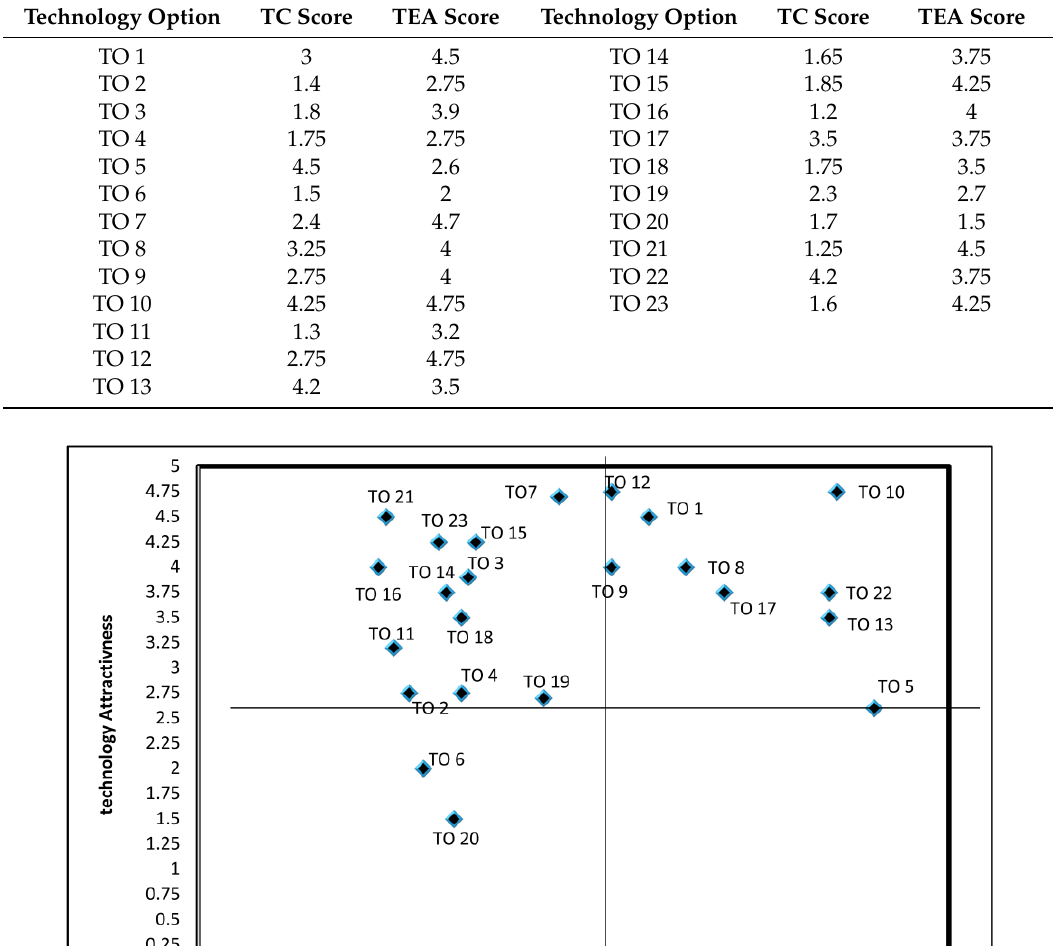
Table 3. Results of technology assessment.